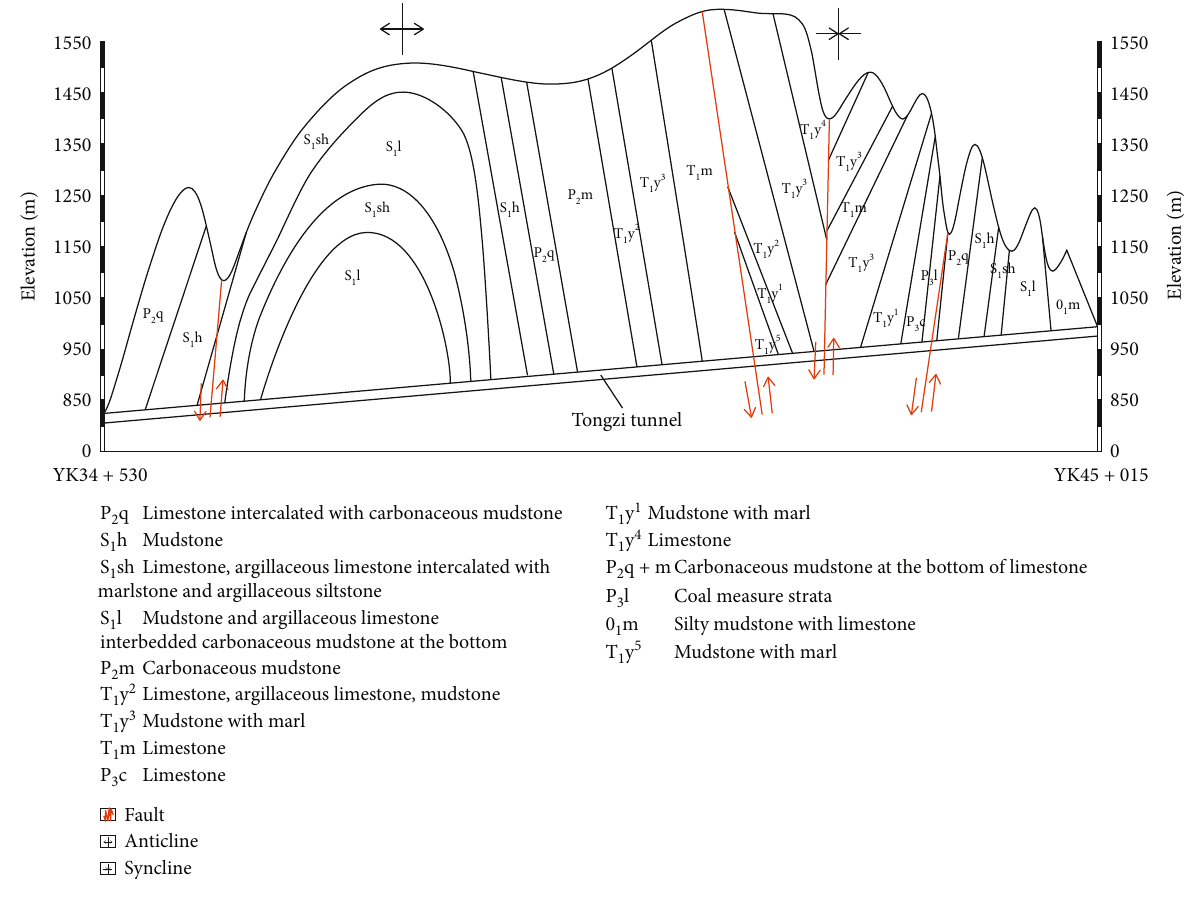
Figure 2: Geological pro fi le of Tongzi